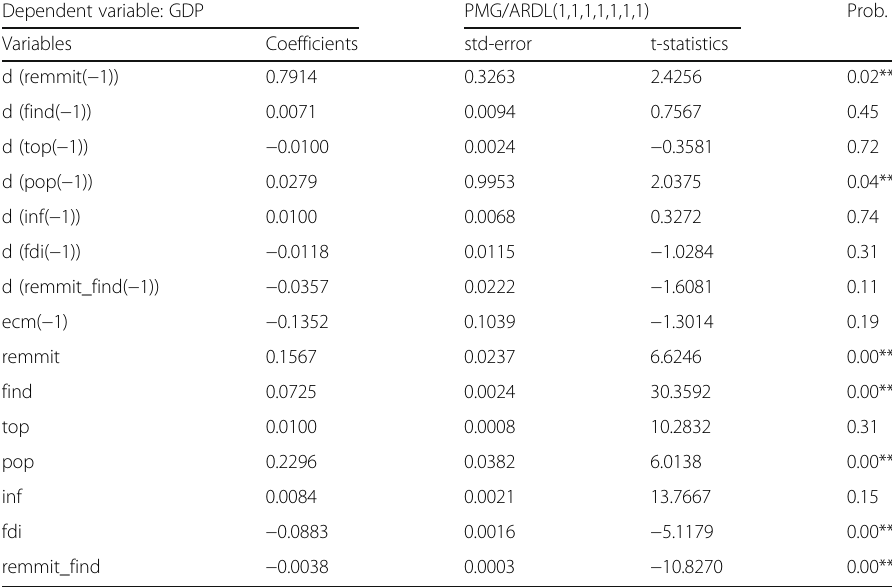
Table 10 The short and long run Pooled Mean Group/ARDL